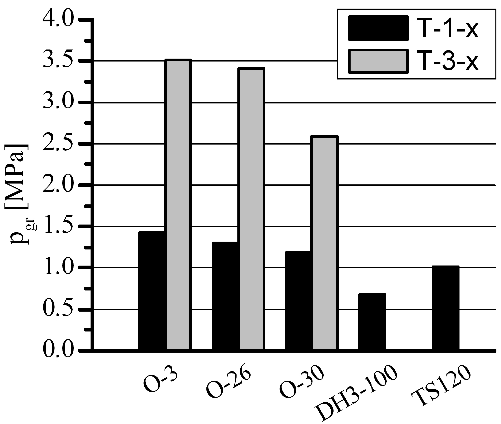
Figure 8. The influence of h-BN on p gr ·v rating of porous sleeves at n = 600 rpm.